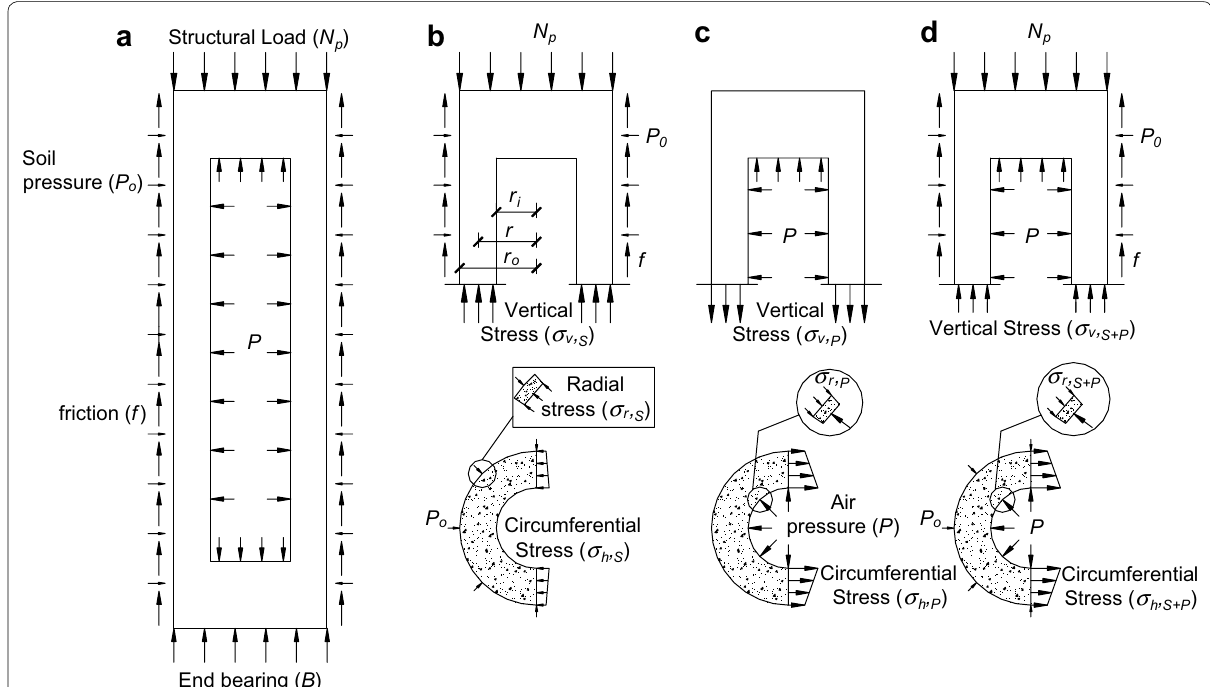
Fig. 1 Stress states of pile foundation: a applied loads; b stresses under the structural load; c stresses under inner air pressure; d stresses under the combined